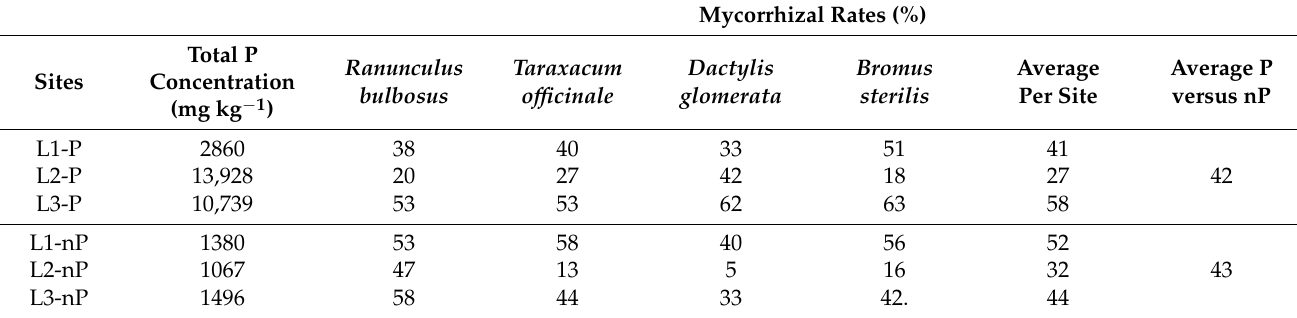
Table 1. Mycorrhizal rates of the four plant species ( Ranunculus bulbosus , Bromus sterilis , Taraxacum officinale, and Dactylis glomerata ) grown on the six sites (L1-P and -nP, L2-P and -nP, and L3-P and -nP). Data based on 135 root fragments from three plants per species in each sampling